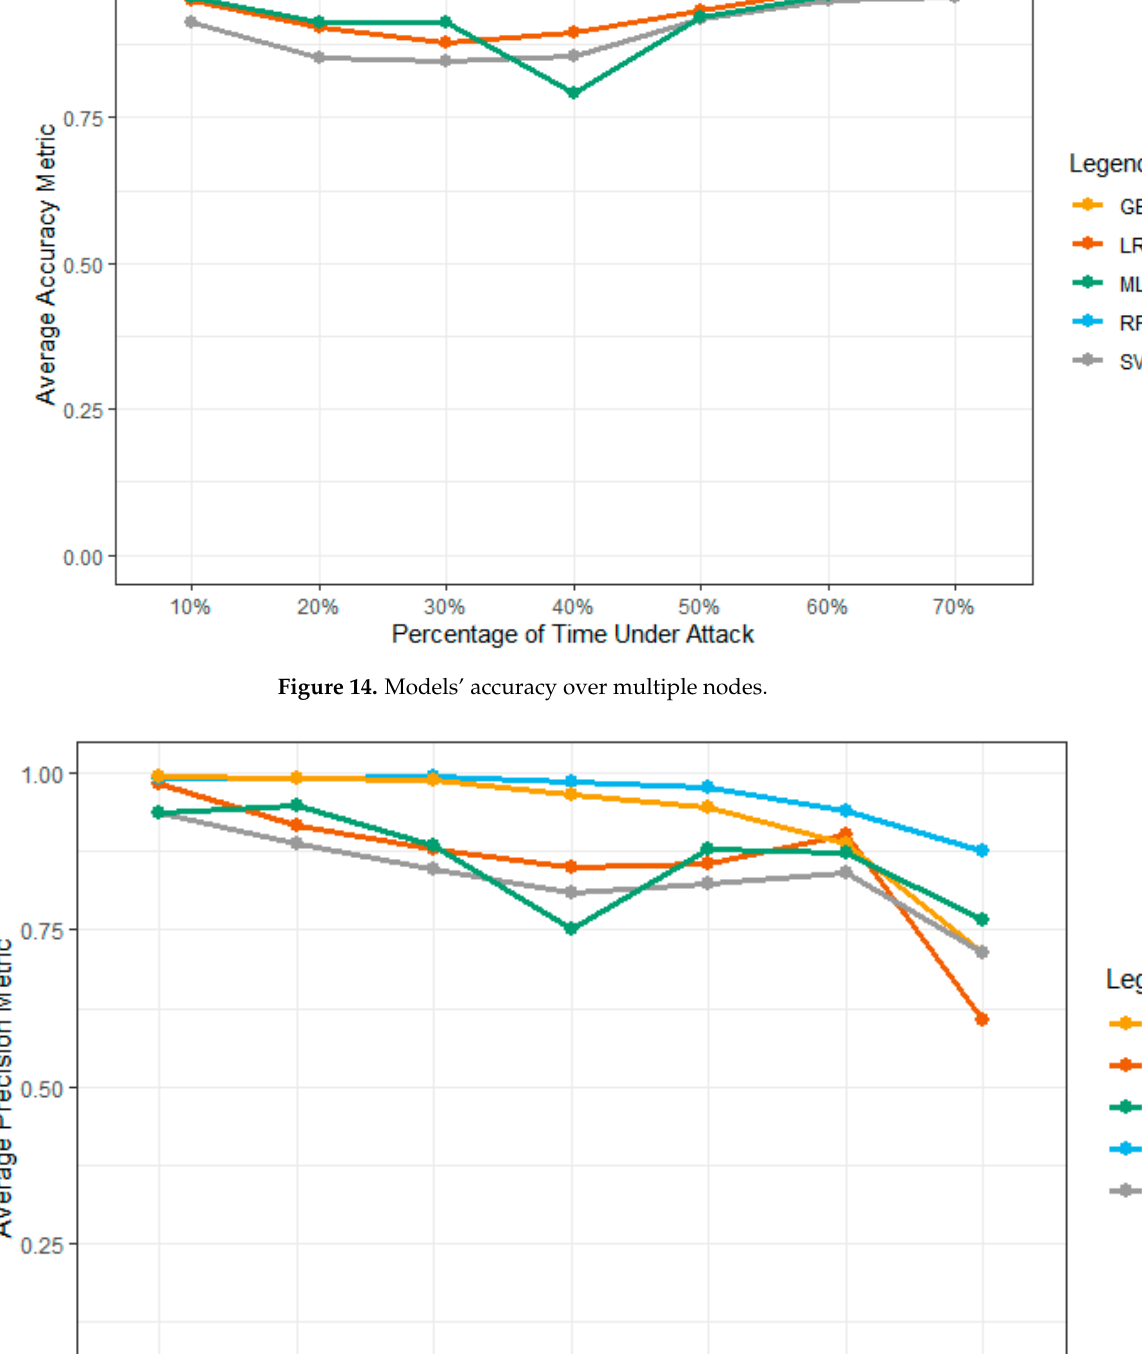
Table 5. Model Precision Results of the network and comparison with other networks.